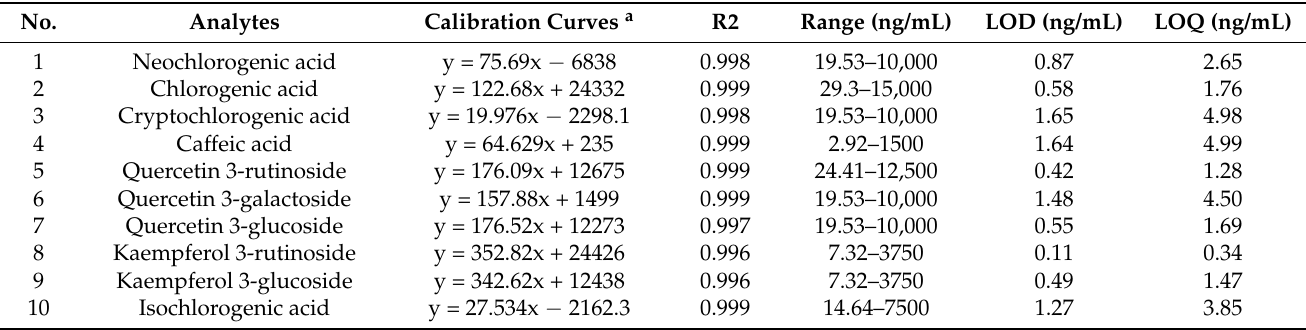
Table 3. Linearity, calibration curves, limit of detection (LOD), and limit of quantification (LOQ) data of 10 compounds.